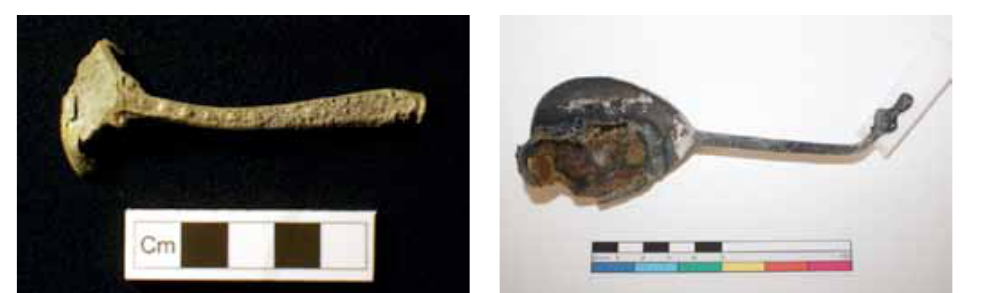
Tin-alloy spoon (86.7) Silver spoon, with ceramic fragment (20.1)